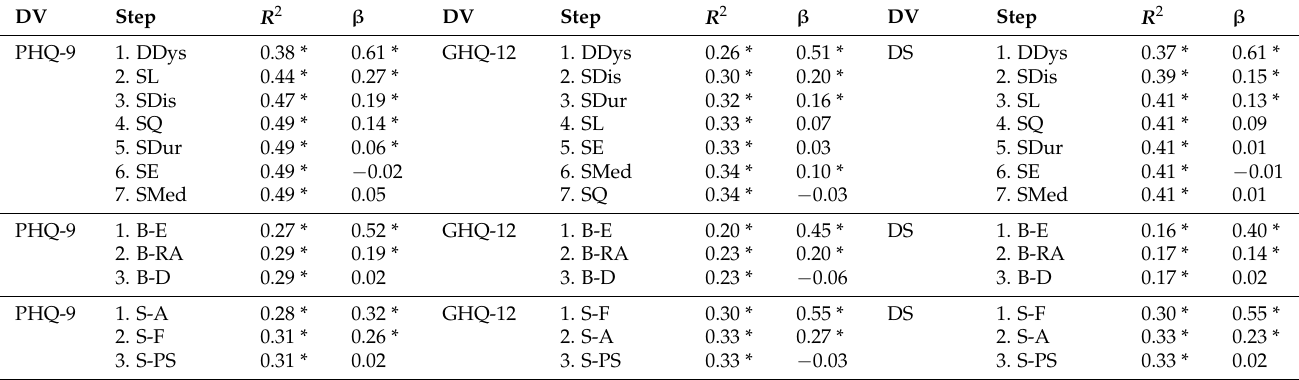
Table 3. Hierarchical regression analyses: Effects of variables on mental ill